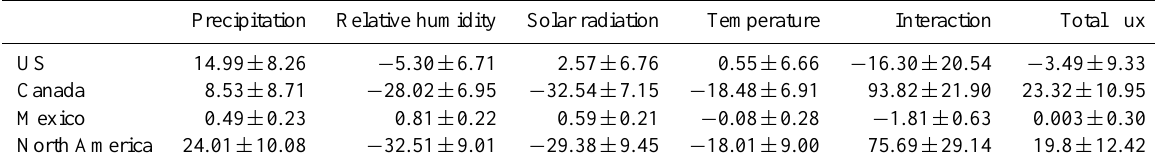
Table 5. Contributions from individual climate variable to the climate-induced CH 4 accumulation (TgC) from 1979 to 2008. Precipitation Relative humidity Solar radiation Temperature